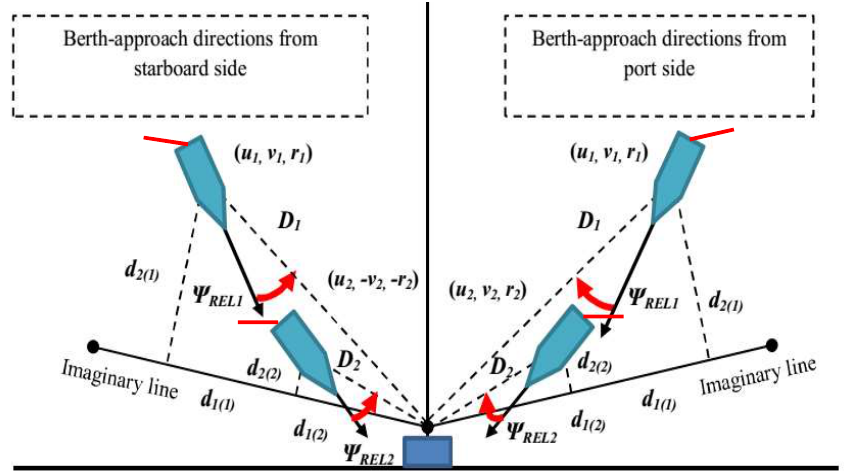
Figure 7. The approach of the berth on each side of ship